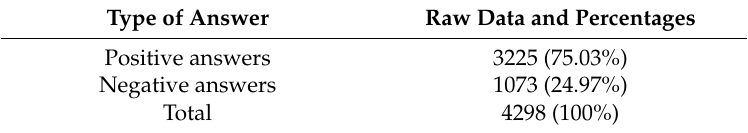
Table 2. Distribution of the answers given by non-executive employees in raw data (and % between brackets).